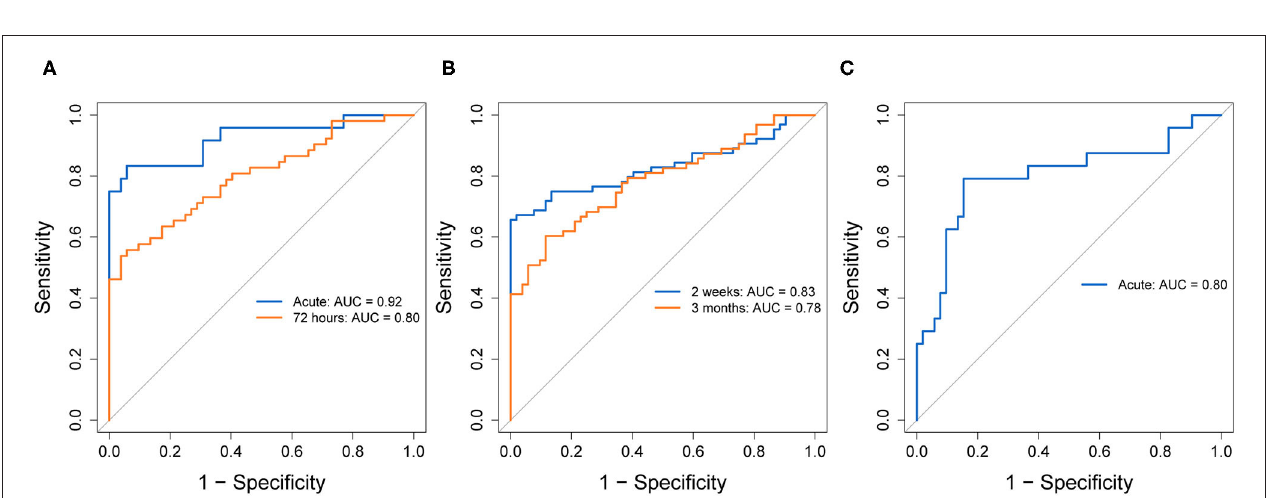
FIGURE 5 | ROC curves indicating diagnostic accuracy of GFAP (A) , NFL (B) , and tau (C) , at selected timepoints, discriminating the mTBI + group from trauma controls. ROC curves for each biomarker’s evaluated timepoints are overlain on the same plot. AUC values and their 95% confidence intervals are indicated in each plot, for each timepoint. GFAP, Glial fibrillary acidic protein; NFL, Neurofilament light; ROC, Receiver operating characteristic; AUC, Area under the curve; CI, Confidence